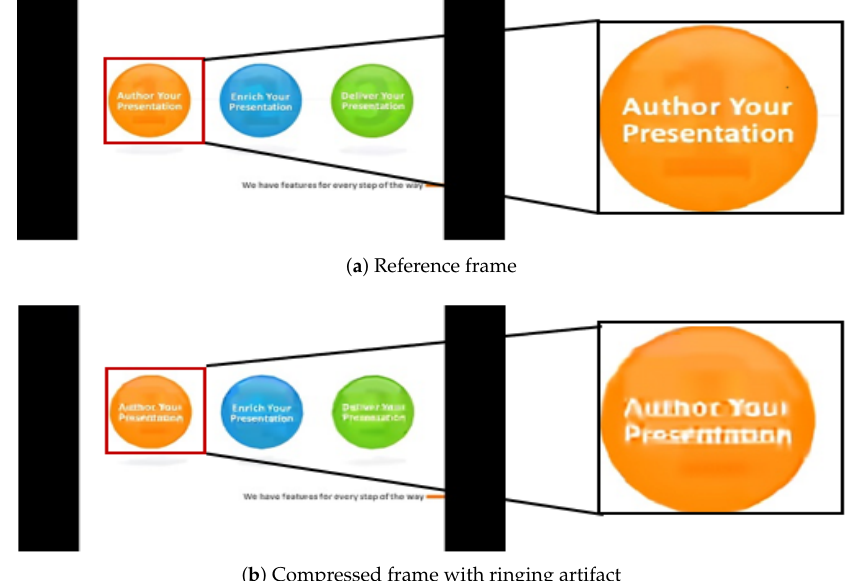
Figure 4. An example of ringing.